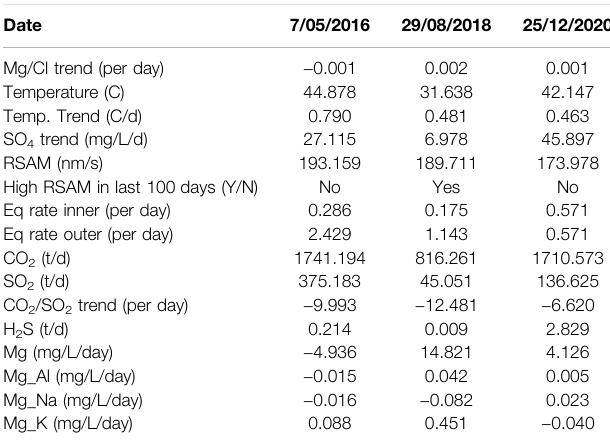
TABLE 2 | The measured values of the monitoring data for each of the three case study dates presented in Figure 12